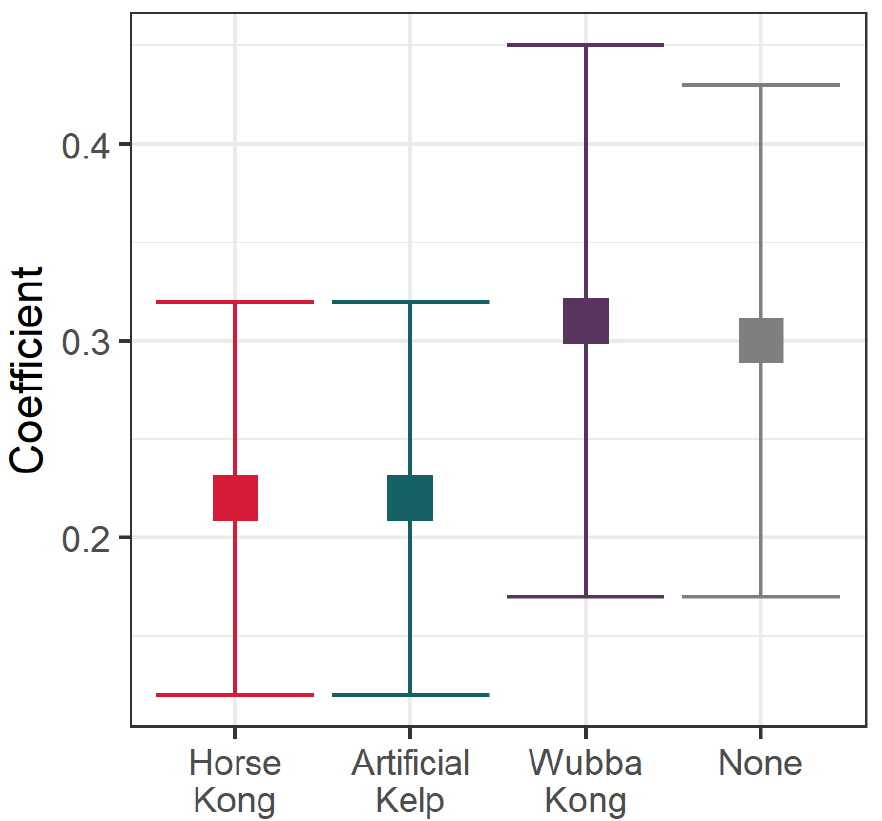
Figure 5. Coefficients from a Poisson GLMM of California sea lions (CSL) displaying stereotypic behaviors in relation to the environmental enrichment device (EED) presented.